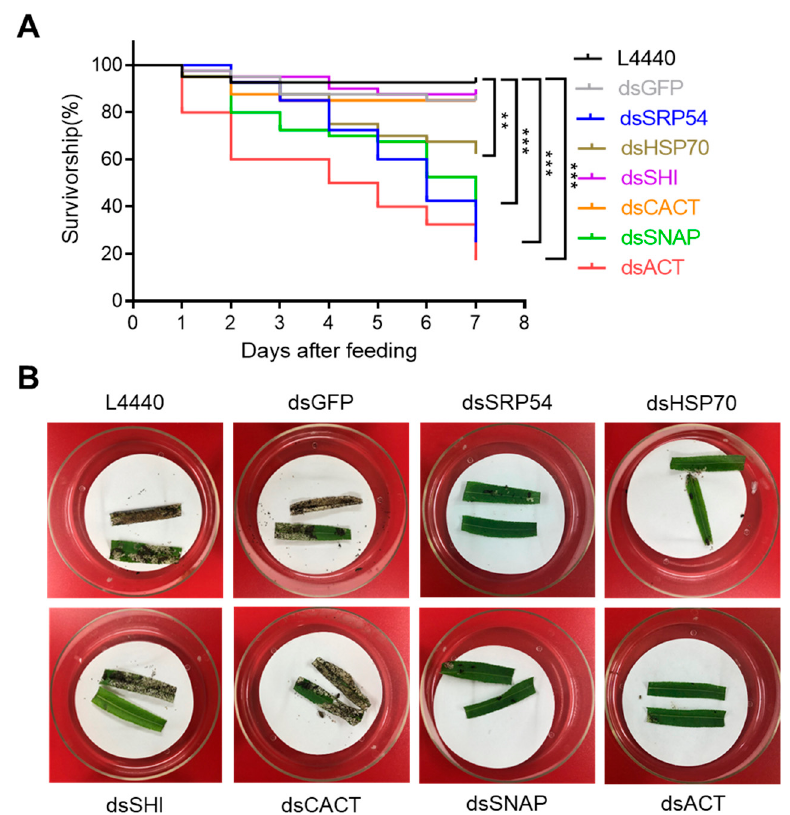
Figure 2. Effects of different dsRNAs expressed in bacteria on the survivorship of the 1st instar larvae. ( A ) Kaplan–Meier survival curves of P. versicolora (N = 40) fed with willow leaves painted with indicated dsRNA-expressing E.coli . The asterisk denotes significant differences (** P < 0.01, *** P < 0.001). ( B ) Example of a bioassay with willow leaves painted with indicated dsRNA-expressing E.coli . Leaves were fed to first instar P. versicolora larvae (N = 40) for four days.